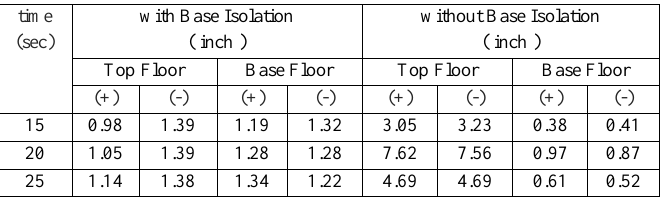
Table 2: difference between top floor and base floor displacement of model for different El centro data.